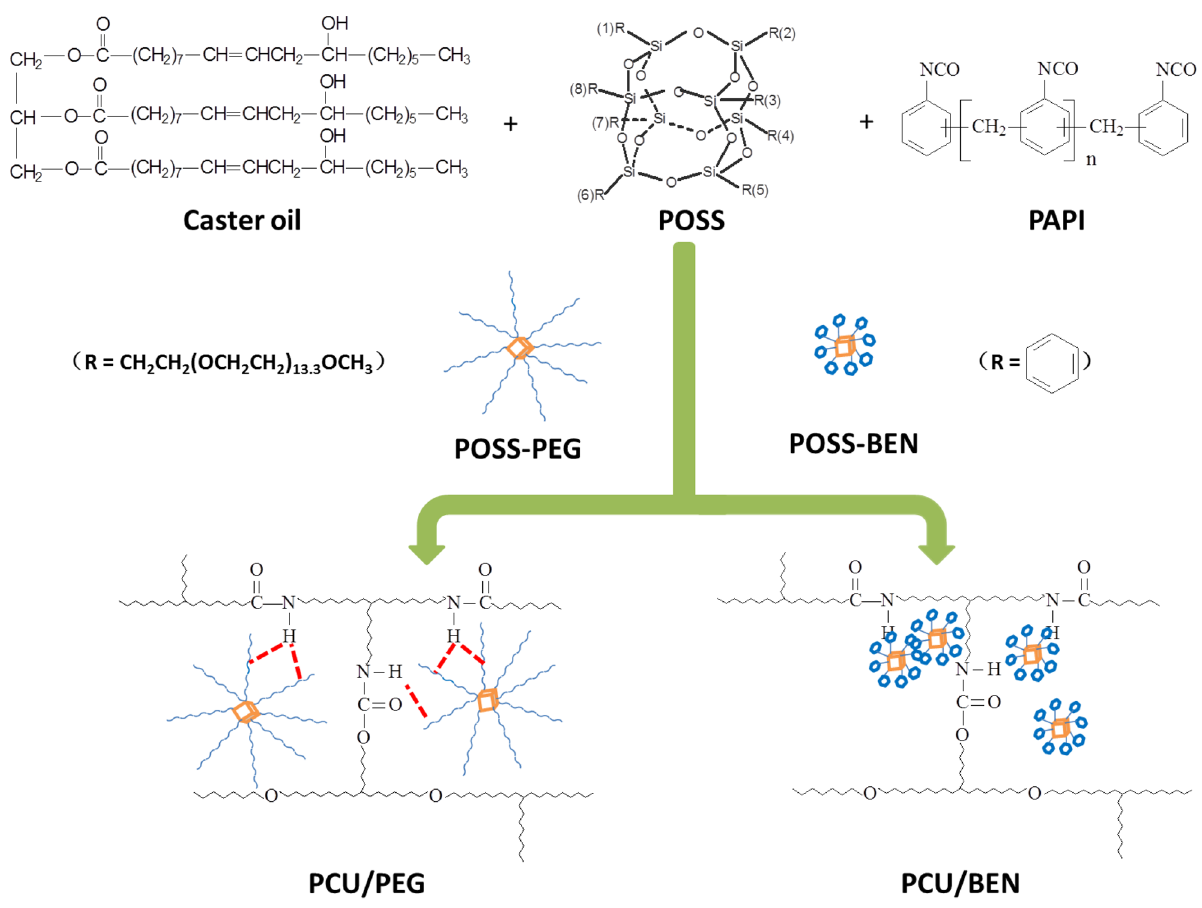
Figure 1. Formation illustration of nanocomposite